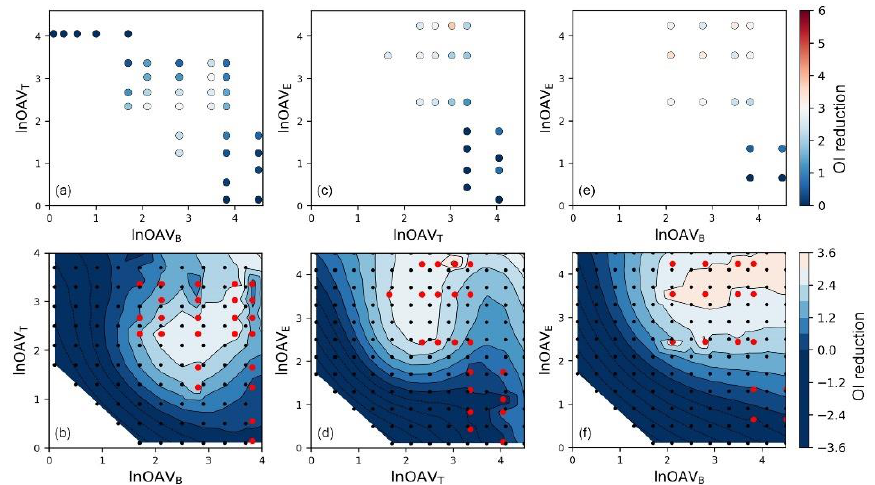
Figure 4. The scatter plot of the relationship between olfactory measured odor intensity reduction degree ( OI reduction ) and components’ ln OAV values, and corresponding contour map after adding SVR model predicted data (in the contour map, red dots: olfactory measured data; black dots: SVR predicted data) for binary mixture ( a , b ) B + T, ( c , d ) T + E, and ( e , f ) B + E.